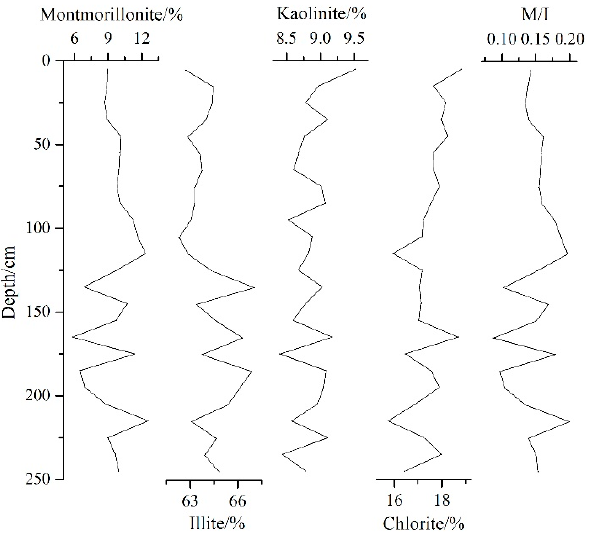
Figure 3. Profile distribution of clay minerals and M/I ratios from GC1601.